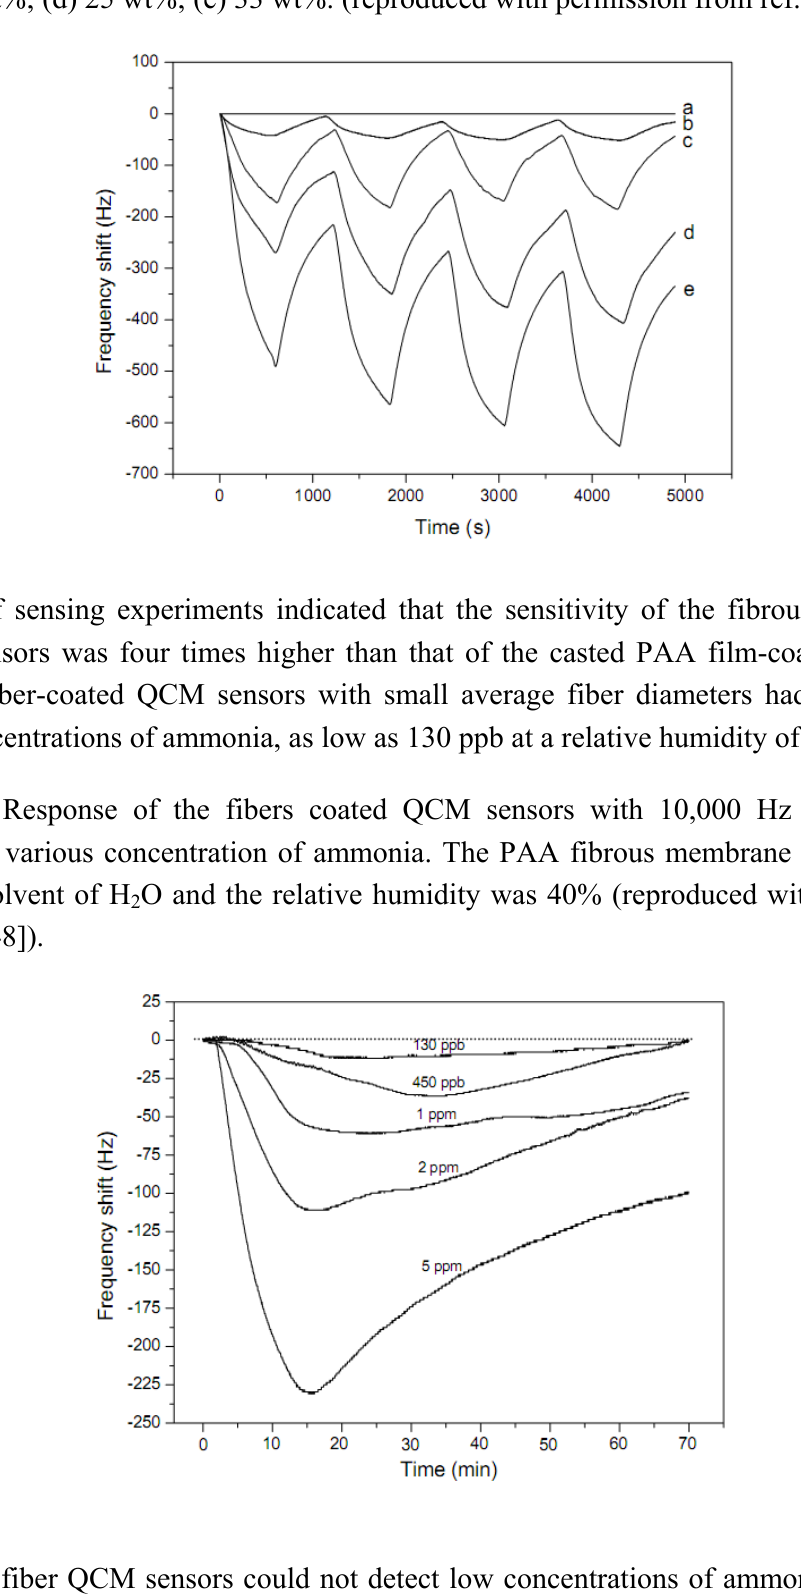
Figure 3. Response of nanofibers coated QCM sensors with various weight percentage of at the relative humidity of 55%. (a) 0 wt%; 11 PAA to PVA exposed to 50 ppm of NH 3 wt%; 18 wt%; (d) 25 wt%; (e) 33 wt%. (reproduced with permission from ref. [47]).